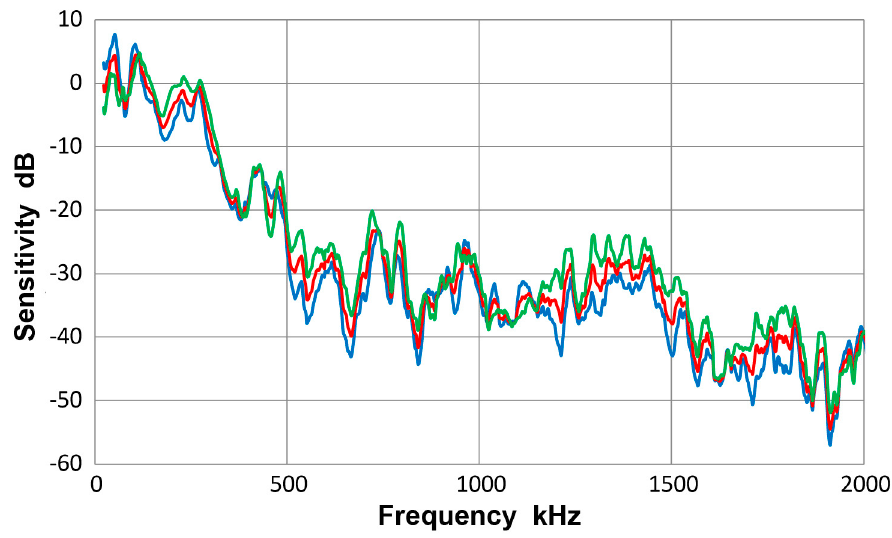
Figure A8. Receiving sensitivity of PAC µ30D sensor. Red -averaged guided wave sensitivity, blue -Lamb waves for 12.7 and 6.4 mm plates, green -bar waves for 12.7 and 6.4 mm bars.